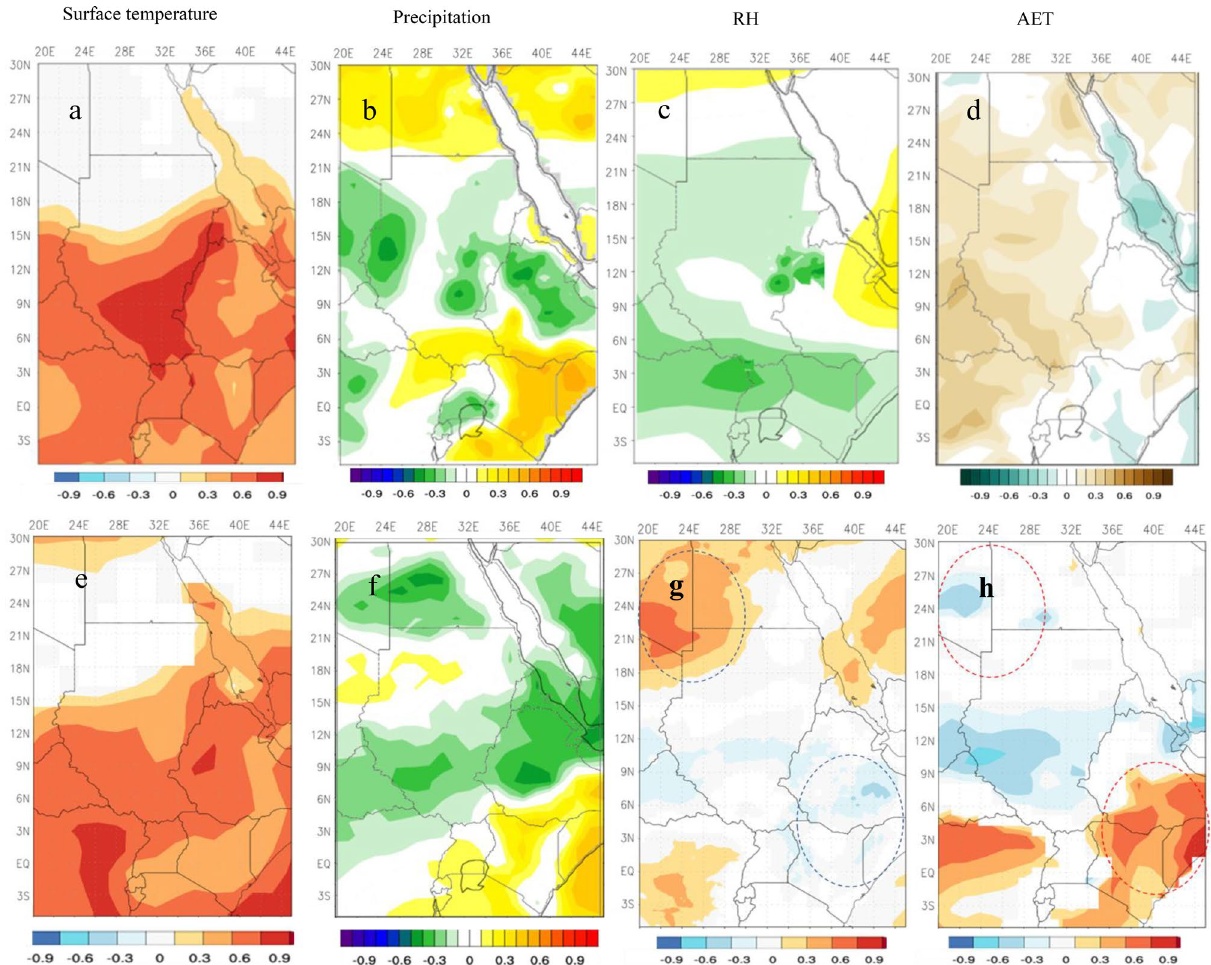
Figure 5. Spatial correlation between NRB’ surface temperature, precipitation, relative humidity, and AET with El Niño 3.4 ( a – d ) and IOD ( e – h ) between 1948:2017 ( p < 5%). In ( b ) the strong negative correlation between El Niño and precipitation in lowland of Ethiopia, Sudan, Uganda, Rwanda, and Burundi indicates that El Niño plays a dominant role in precipitation variability (reduction) in these countries. On the other hand, there is a strong positive correlation between El Niño and precipitation in Kenya, Tanzania, and Egypt implying an increase in precipitation in these countries. In ( d ) the spatial relationship between AET and El Niño is a mirror- opposite of the relative humidity—El Niño relationship ( c ) because of the strong dependence between relative humidity and evaporation rate i.e., a decrease in relative humidity causes evaporation rate to increase. In e, IOD intensified ENSO-induced warming in the upper part of the NRB. In addition, IOD seems to amplify ENSO impact on the NRB’s precipitation variability with reduced precipitation in Eritrea, Ethiopia, Sudan, Congo, and Egypt, and increased precipitation over Uganda, Kenya, Tanzania, Burundi, and Rwanda ( f ). In g and h, RH and AET show an almost opposite pattern to their relationship with ENSO. The maps were generated with NCAR Command Language (NCL) Version 6.2.1 (http:// www. ncl. ucar.